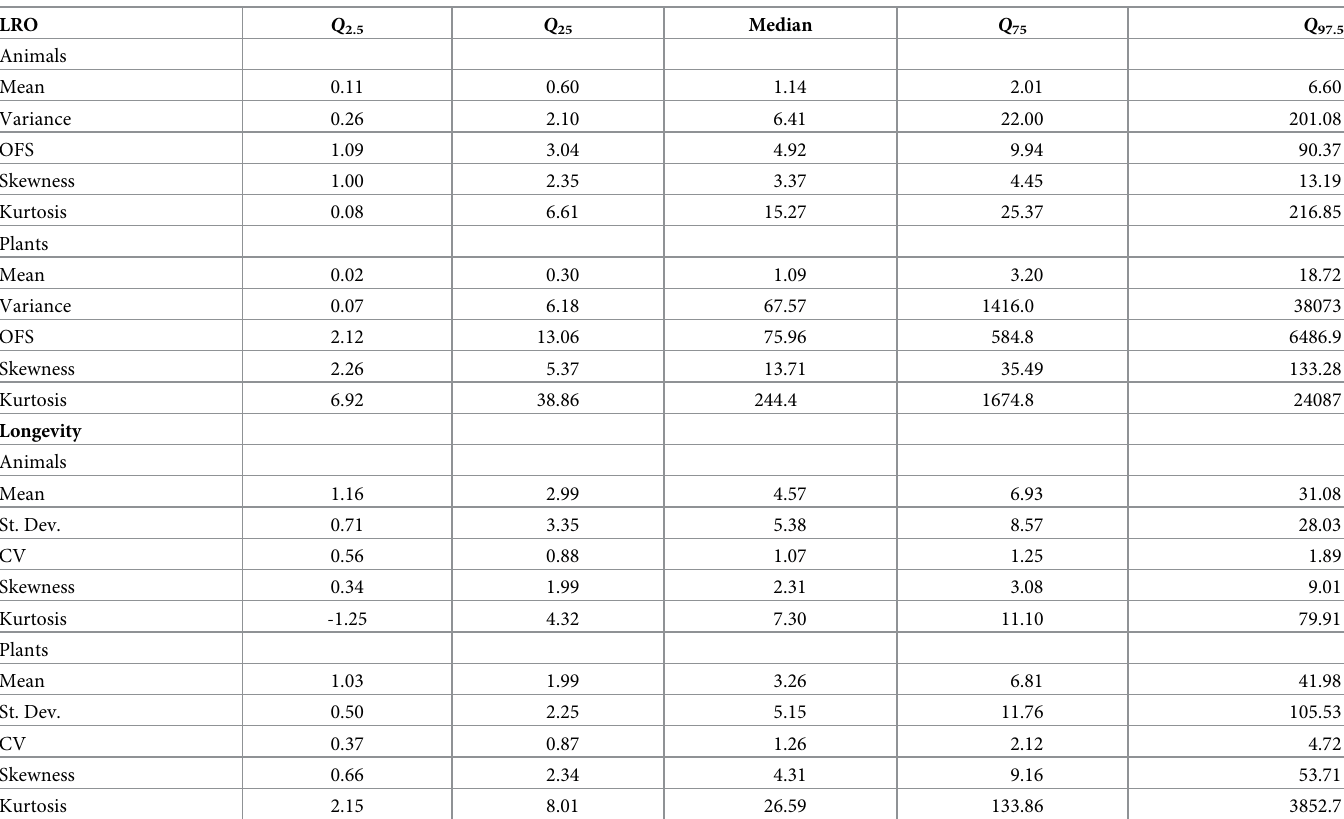
Table 1. Quantiles of lifetime reproductive output (LRO) and longevity for the subsets of animals and plants.